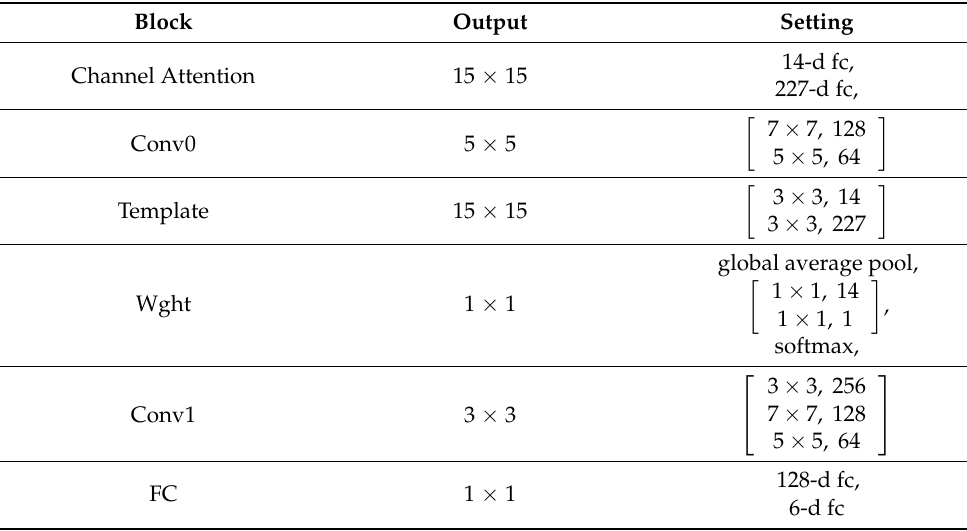
Table 2. The layers in each block of regression head. Each row denotes a convolutional layer (size, kernels) with a default stride of 1 and padding of 0, followed by rectified linear units